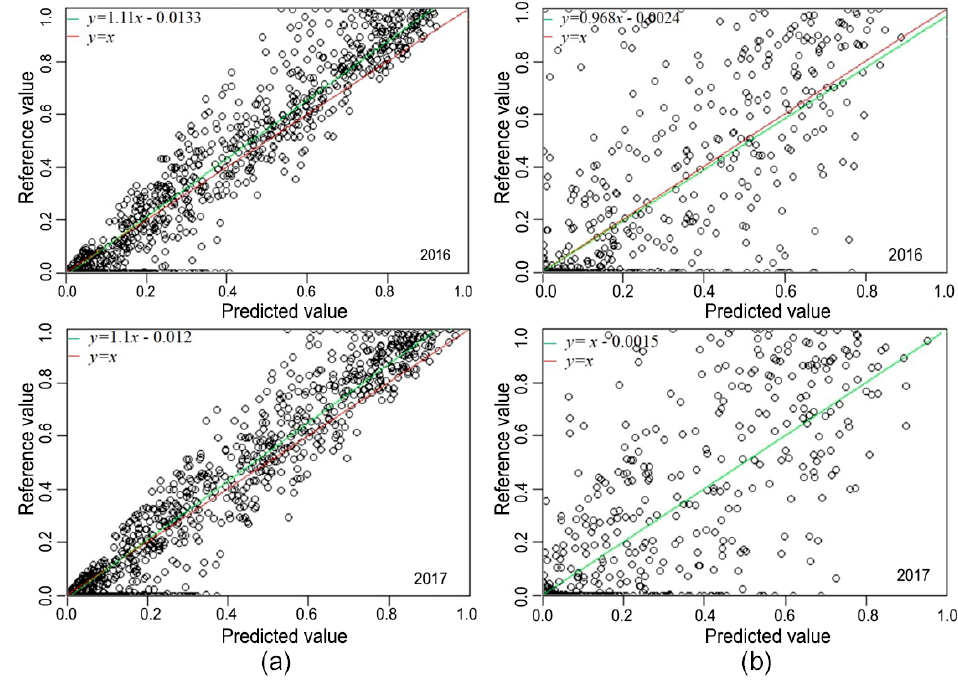
Figure 4. Performance of the random forest (RF) model for 2014–2017. ( a ) Model fitting value and training sets. ( b ) Model prediction value and independent validation sets.